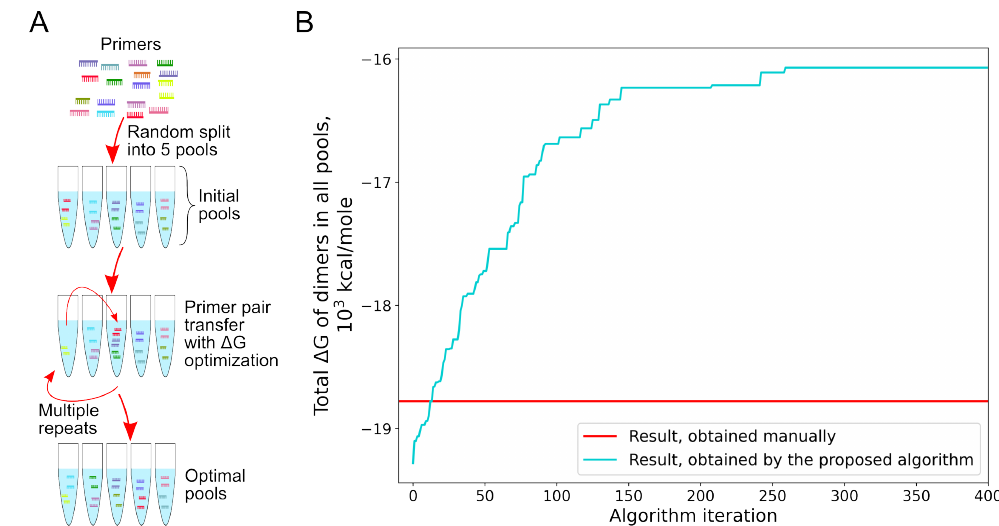
Figure 4. ( A ) A scheme of the iterative algorithm for optimizing large primer pools. ( B ) The graph shows the relationship between the number of optimization steps and the total ∆ G of all generated dimers across all pools. One optimization step means “fitting” procedure for a single primer pair with its possible transfer between pools.